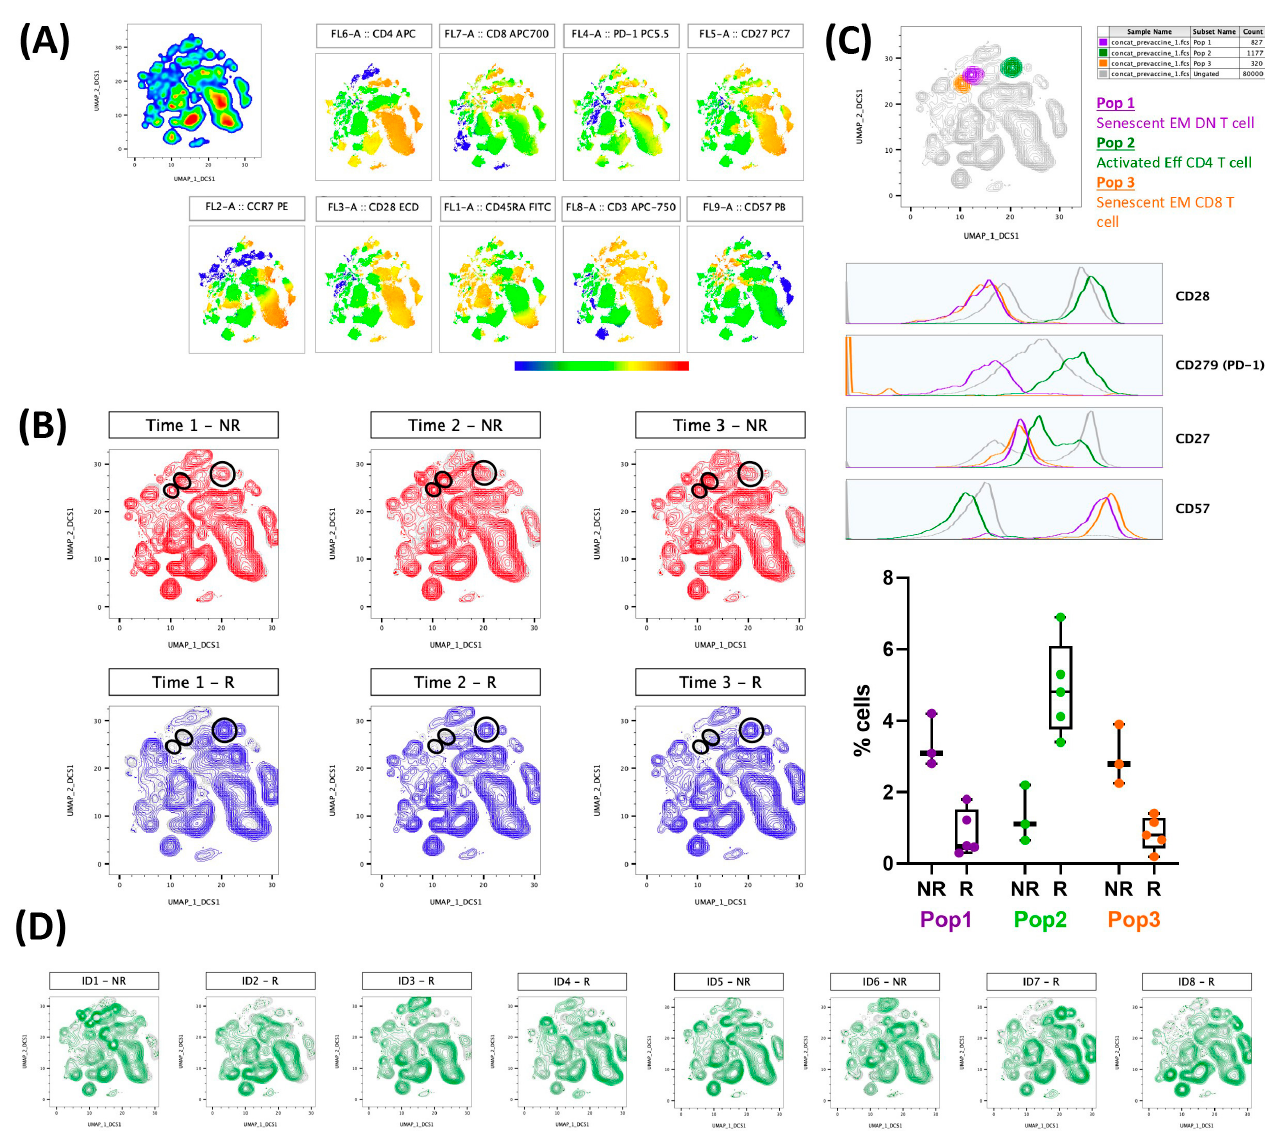
Figure 2. Activated T cells are related to the production of neutralizing antibodies, and, on the other hand, senescent T cell populations can impair this production by volunteers vaccinated with CoronaVac. Whole blood collected before fi rst Coronavac dose was analyzed by fl ow cytometry. Analysis were performed using FlowJo software. A total of 10,000 lymphocytes from each volunteer were concatenated before performing unsupervised analysis. Neutralizing antibody production was evaluated after fi rst (22 to 34 days, time 1), second (30 to 38 days, time 2), and 90 days (88 to 103 days, time 3) after second dose Coronavac vaccine. ( A ) Colormap graphs for lymphocytes populations present in whole blood from volunteers before Coronavac vaccination. ( B ) UMAP graphs showing volunteers that produced (R—blue) or did not produce (NR—red) neutralizing antibodies after Coronavac vaccination. ( C ) Top: UMAP graph and histograms showing the cell populations found in responder (Pop 2—green) or non-responder (Pop 1—purple and Pop 3—orange) volunteers. Down: Frequencies of populations 1-3 for R and NR 90 days after second dose Coronavac vaccine, including individual values, median, and interquartile range. ( D ) UMAP graphs representative of each volunteer individually, considering R and NR 90 days after second dose Coronavac vaccine. EM = e ff ector memory; E ff = e ff ector; DN = double-negative. Based on the fact that the two non-responder volunteers presented a higher frequency of senescent T cells than the responder volunteers, we performed an evaluation of